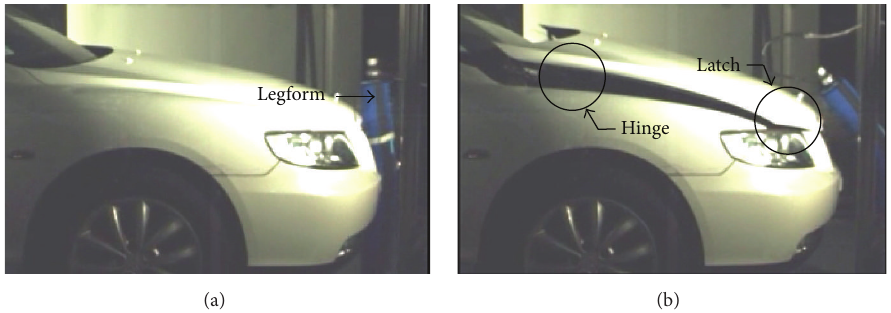
Figure 1: Operation photographs of vehicle equipped with AHLS: (a) before and (b) after